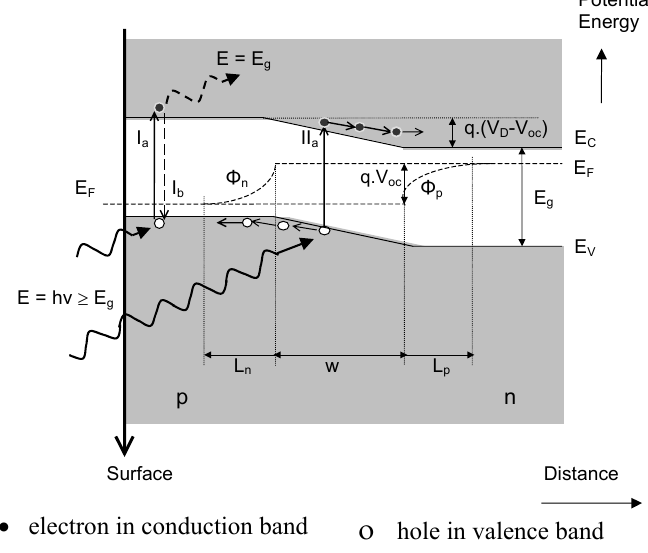
) separated by a ) will not be separated a g